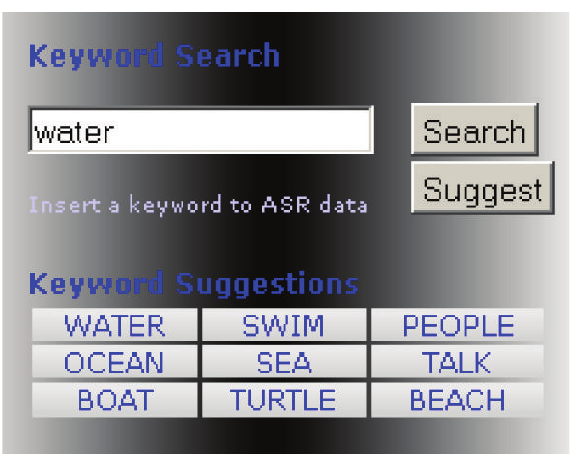
Figure 11: Keyword suggestions for a text-based